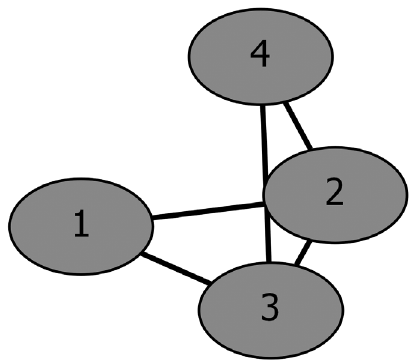
Figure 14. The PNG of the exported DOT file created with Graphviz’s neato